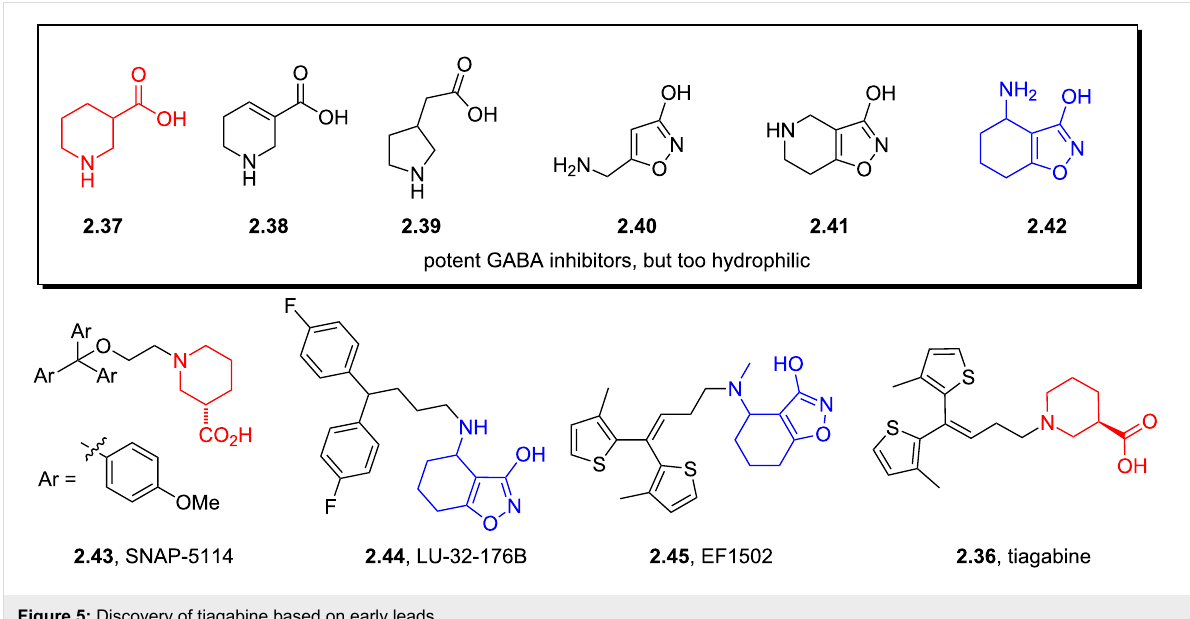
towards hERG channels. Consequently, careful and early-stage examination of hERG affinity is nowadays a vital part of assessing preclinical risks of new drug candidates